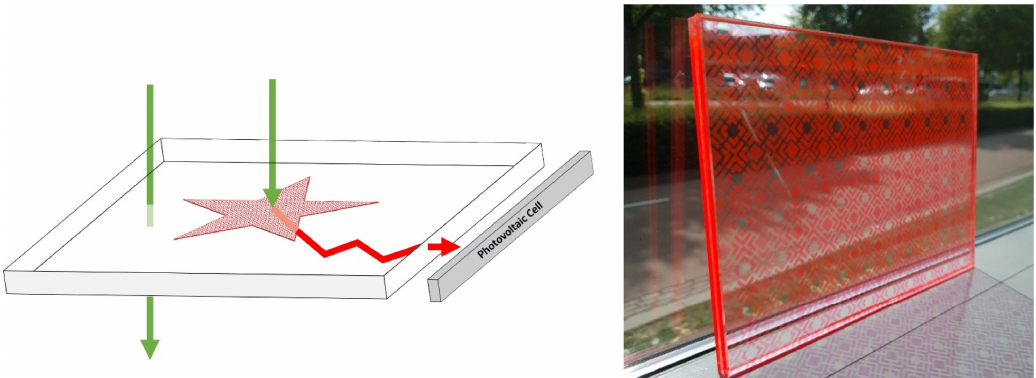
Figure 4. Working principle of inkjet-printed luminescent solar concentrator and photograph of a printed A4 sized luminescent solar concentrator [109].